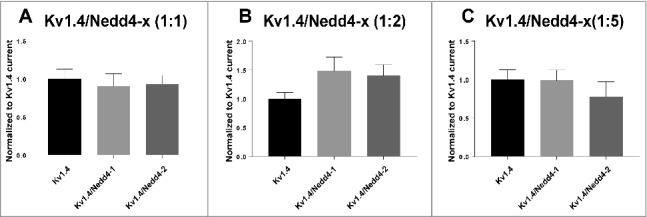
Co-expression of Kv1.4 channels with different ratios of Nedd4-x. TEVC recordings of Xenopus laevis oocytes expressing Kv1.4 channels with either Nedd4-1 or Nedd4-2. The current levels were measured at peak amplitude at the +30 mV pulse and normalized to the peak current for Kv1.4 expressed alone. (A) Kv1.4 and Nedd4-1 or Nedd4-2 in a molar ratio of 1:1. (B) Kv1.4 and Nedd4-1 or Nedd4-2 in a molar ratio of 1:2. (C) Kv1.4 and Nedd4-1 or Nedd4-2 in a molar ratio of 1:5. 7 ≤ n ≤ 17 for each group. Noteworthy, no change was observed on current kinetics following Nedd4-x co-expression (data not shown).